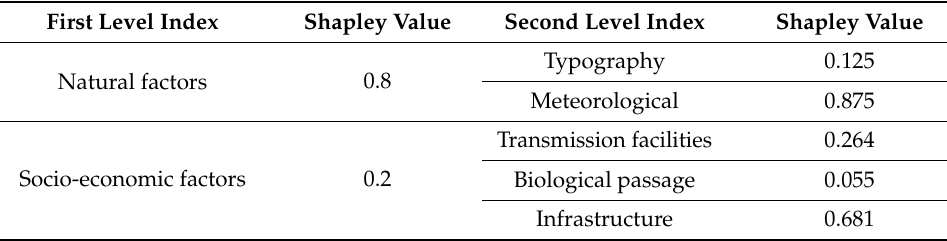
Table 2. The Shapley value of the first and second level index.